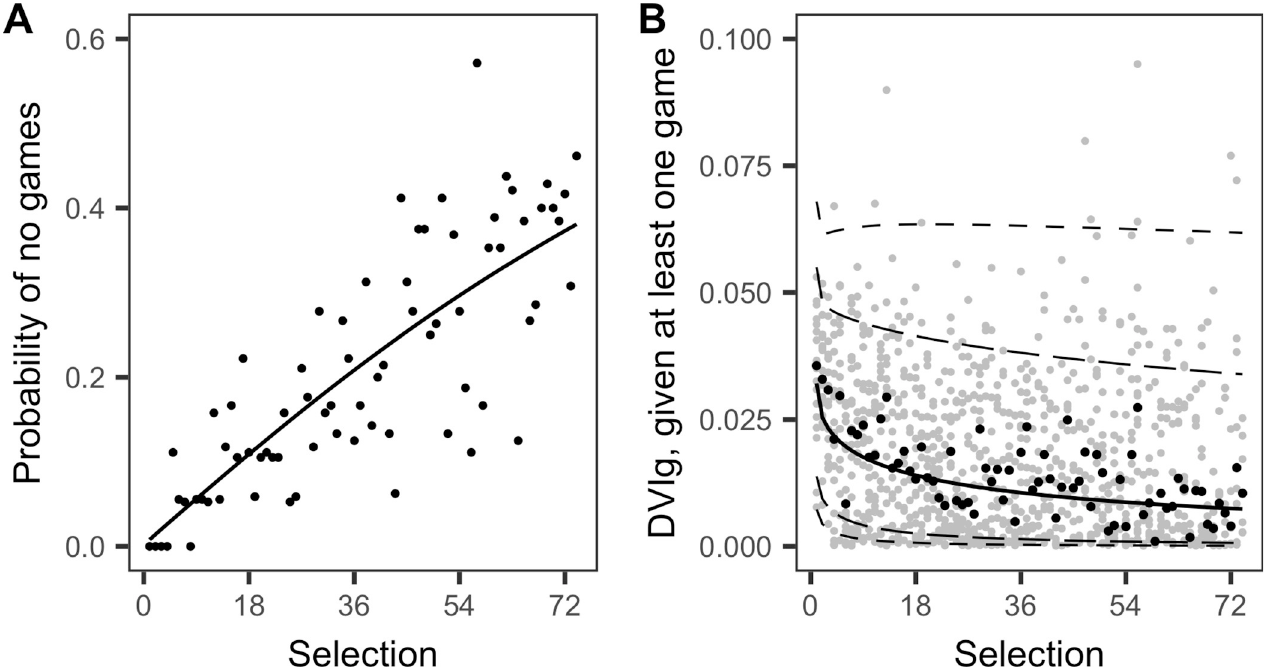
Fig 4. Estimated DVIg values. (A) Observed and best-fit estimate of the probability a player fails to play a game in relation to their selection. (B) Observed (grey circles) and best-fit DVIg distribution for players that played at least one game. Black circles depict medians of the observations. Variation in DVIg is modelled using the Weibull distribution. Solid line depicts the predicted median. Short- and long-dashed lines depict the bounds associated with the 95% and the 80% prediction intervals, respectively.